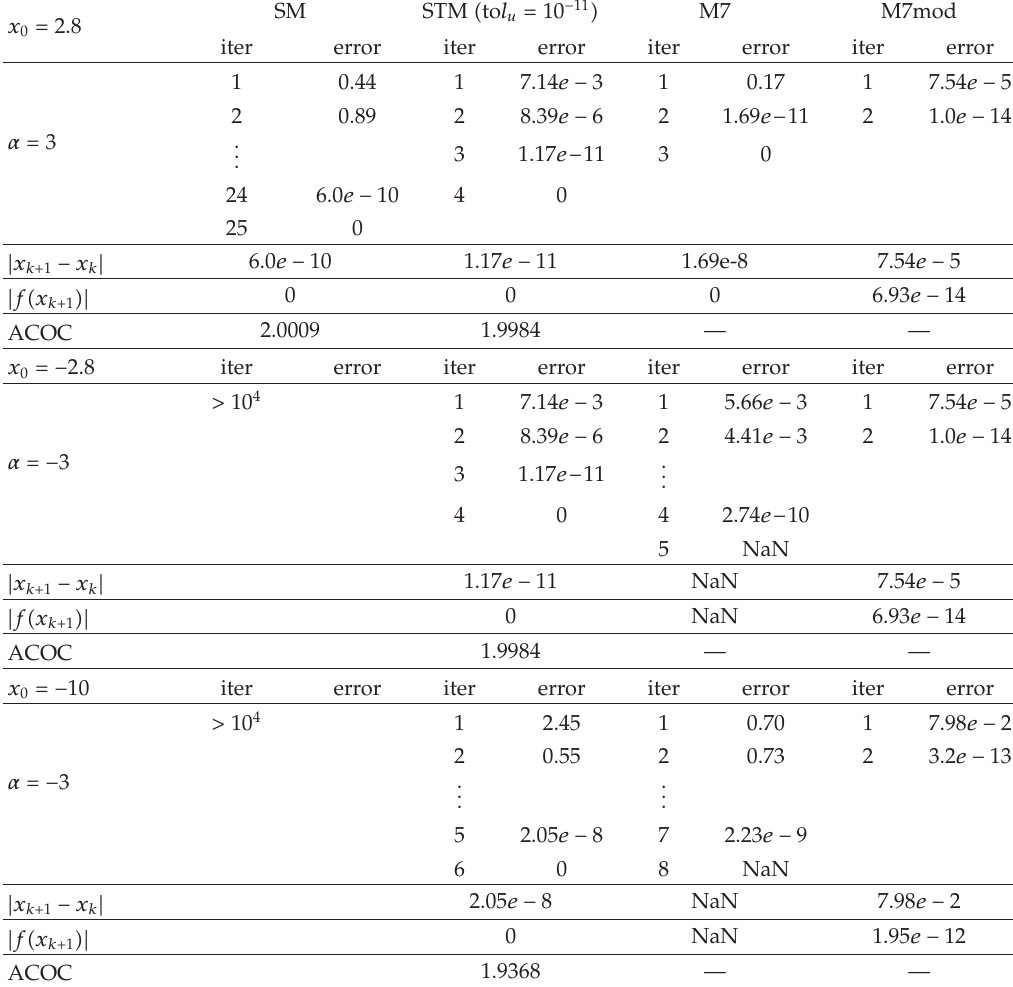
(cid:4) x (cid:5) 12